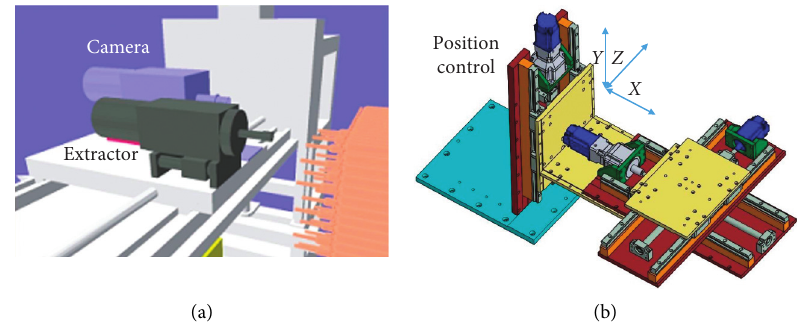
Figure 4: (a) Vision and (b) data positioning methods for extraction.